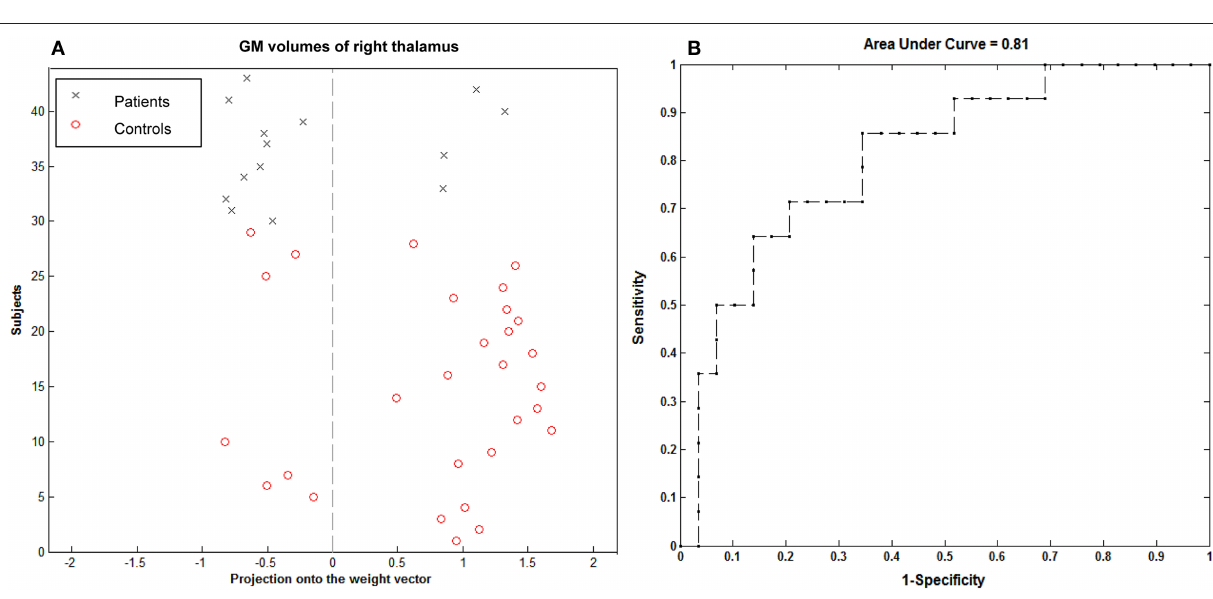
FIGURE 6 | Classification plot (A) and receiver operating characteristic curve (B) for the comparison between 14 children with GTCS and 29 healthy controls using GM volume from right thalamus of T1-weighted images. This yielded a total accuracy of 74.42% (75.86% sensitivity, 71.43% specificity), statistically significant at P <